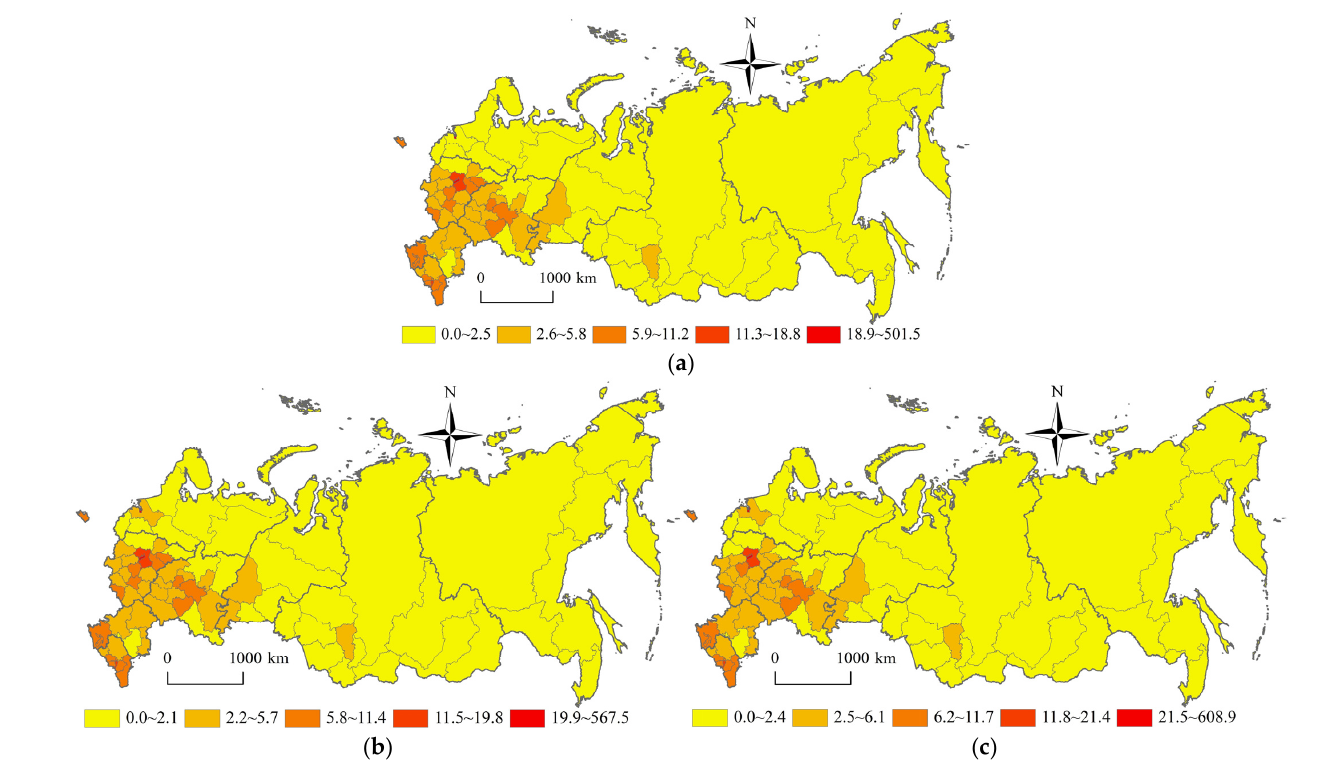
Figure 3. Spatial pattern of Russia’s population concentration degree during 2002–2020. ( a ) 2002 year ( b ) 2010 year ( c ) 2020 year.